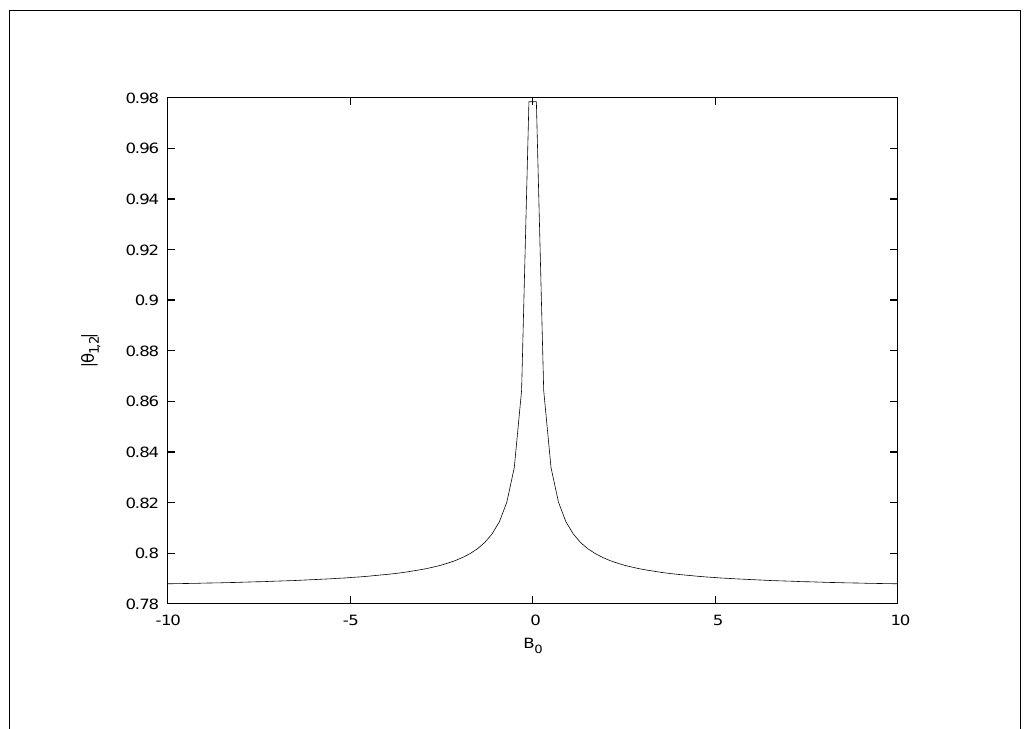
Figure 4. Variation of flavor mixing angles in radian as functions of gravitational coupling in units of eV with m e = 0.01 eV, m µ = 0.1 eV and m µ e = 0.05